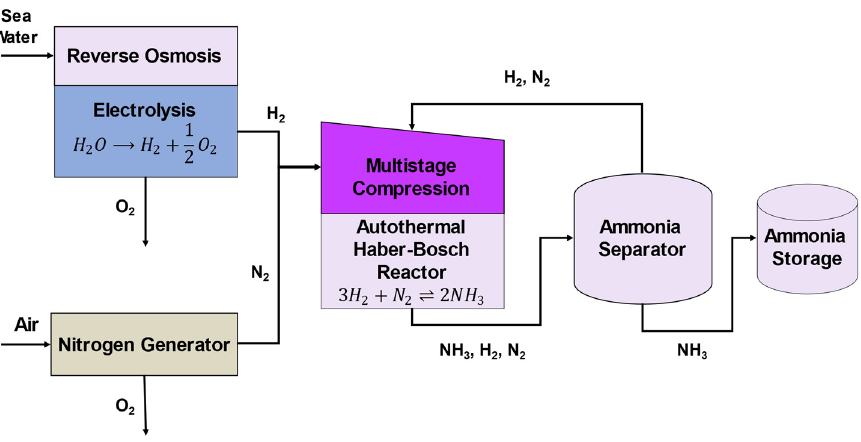
Figure 1. Process Flow Diagram for the Power to Ammonia (P2A) Production